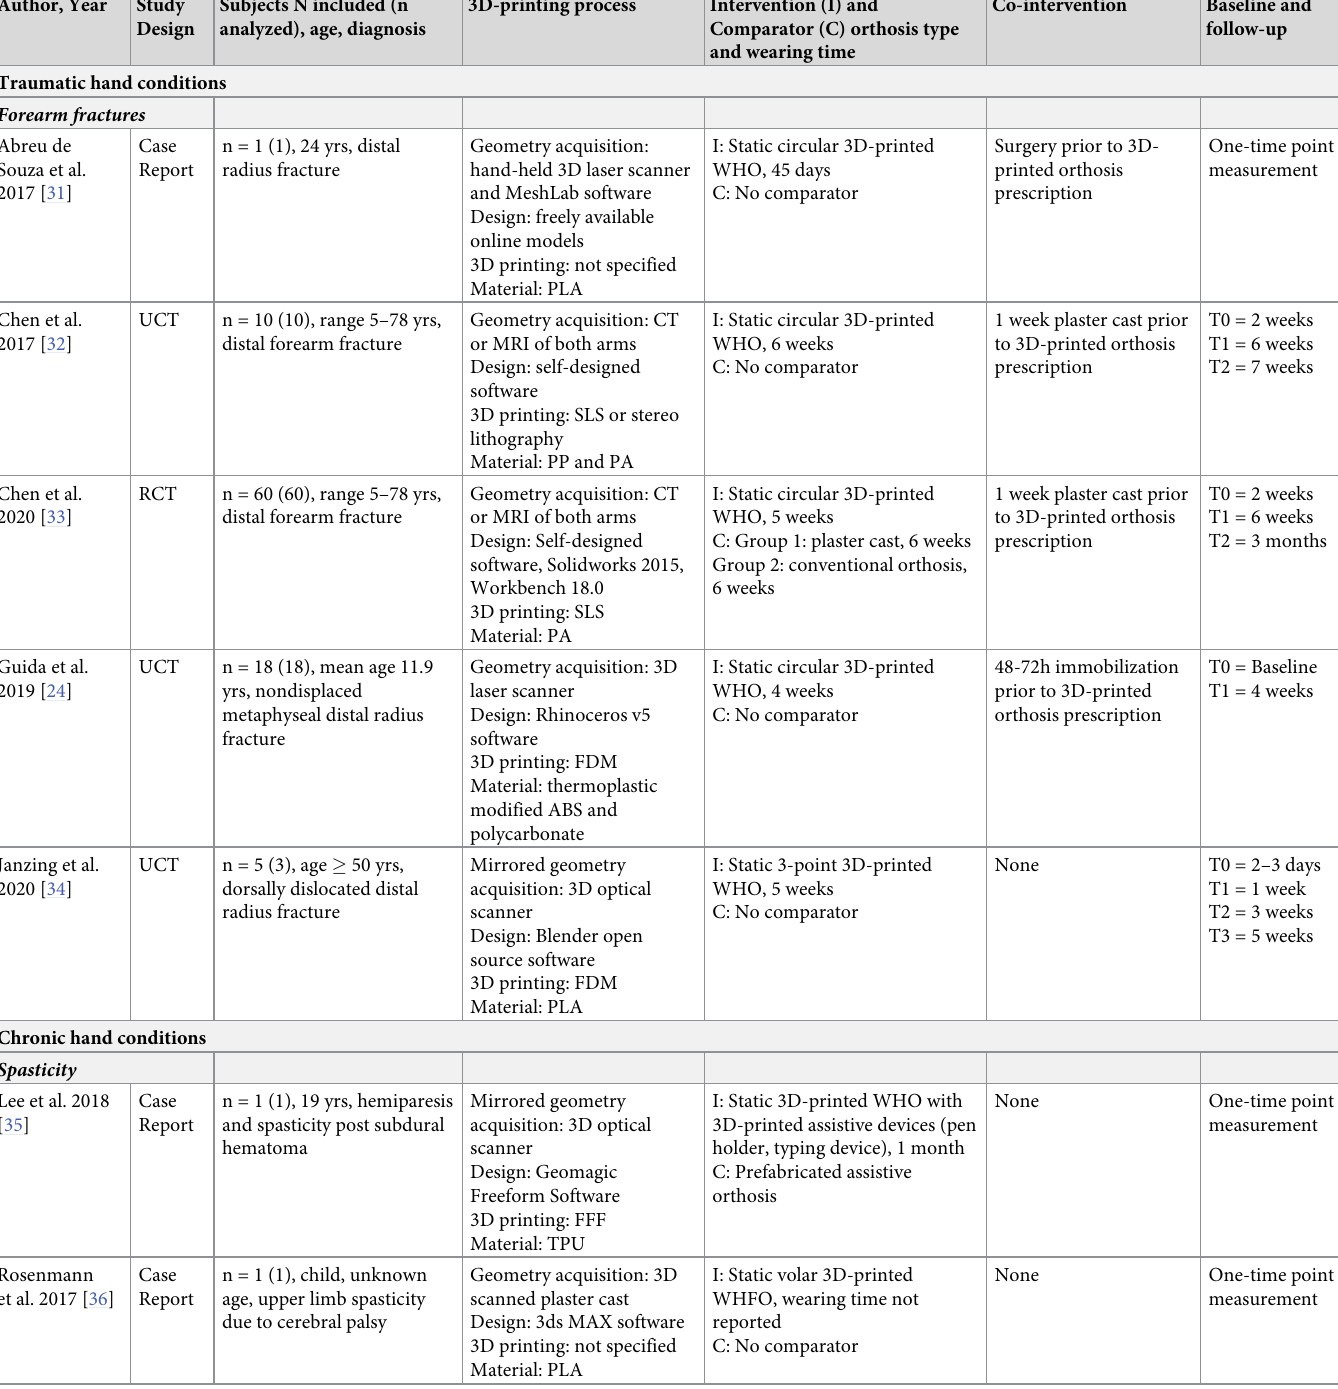
Table 2. Study characteristics by type of